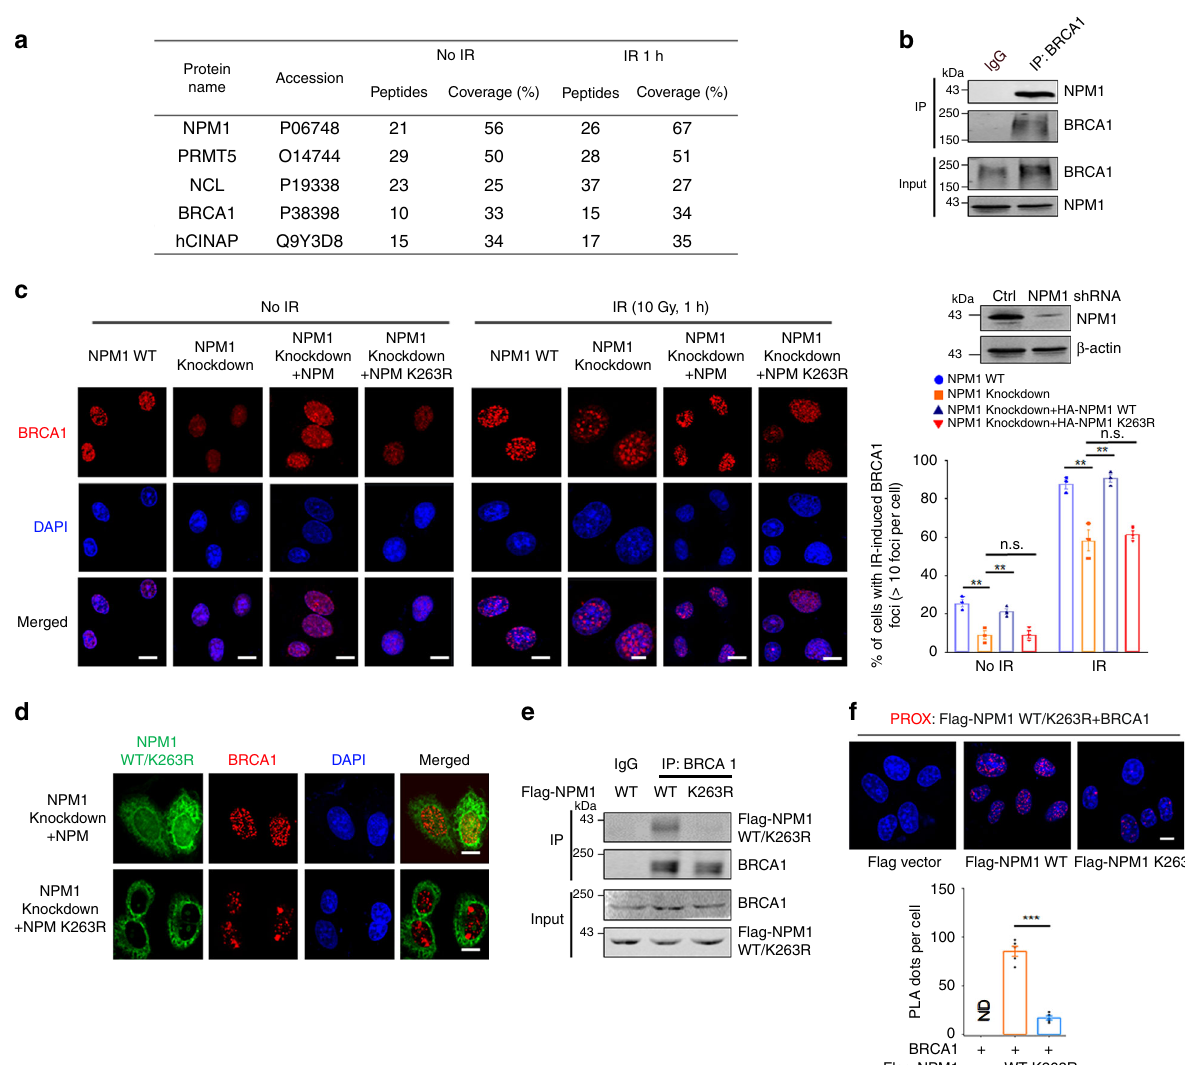
Fig. 4 NPM1 SUMOylation promotes DSB-induced BRCA1 accumulation. a HEK293T cells harboring the Flag-empty vector or Flag-NPM1 were treated with or without IR (6 Gy) and then lysed and subjected to af fi nity puri fi cation using anti-Flag M2 af fi nity beads. The puri fi ed protein complex was analyzed via mass spectrometry. The major hits from mass spectrometry are shown in the table. b The interaction between NPM1 and BRCA1 was con fi rmed using a Co-IP assay with the indicated antibodies. c Immuno fl uorescence assays to analyze the effect of NPM1 SUMOylation on IR-induced BRCA1 foci. U2OS cells with depleted NPM1 were rescued with or without wild-type NPM1 or the NPM1 K263R mutant and treated with or without IR (10 Gy). Representative images are shown and the percentage of cells with more than 10 BRCA1 foci were counted. Scale bar, 10 μ m. The results are presented as the mean ± SEM of three biological replicates. Statistical analysis was performed using the Student ’ s t test; ** P < 0.01, *** P < 0.001. Approximately 100 cells in each group were counted. d HeLa cells infected with lentivirus expressing NPM1 shRNA were transfected with wild-type NPM1 or K263R mutant. After transfection, cells were exposed to 6 Gy IR and then recovered for 1 h before being subjected to immuno fl uorescence using antibodies against NPM1 and BRCA1. Representative NPM1 WT/K263R, BRCA1 foci, and DAPI-stained nuclei are shown. Scale bar, 10 μ m. e HEK293T cells transfected with Flag-NPM1 WT or K263R mutant vectors were subjected to co-IP analysis using the indicated antibodies. f U2OS cells transfected with Flag-NPM1 WT or K263R were grown on collagen-coated microchamber slides. After fi xation, the interaction between BRCA1 and NPM1 WT or K263R was detected by in situ PLA using anti- Flag and anti-BRCA1 antibodies. The PLA-detected proximity (PROX) complexes are represented by the fl uorescent rolling circle products (red dots). Scale bar, 10 μ m. Quanti fi cation of the PROX dots per cell is shown as mean ± SEM with the P value indicated. *** P < 0.001. The source data can be found in Supplementary Data 1. Unprocessed scans of blots are provided in Supplementary Fig.